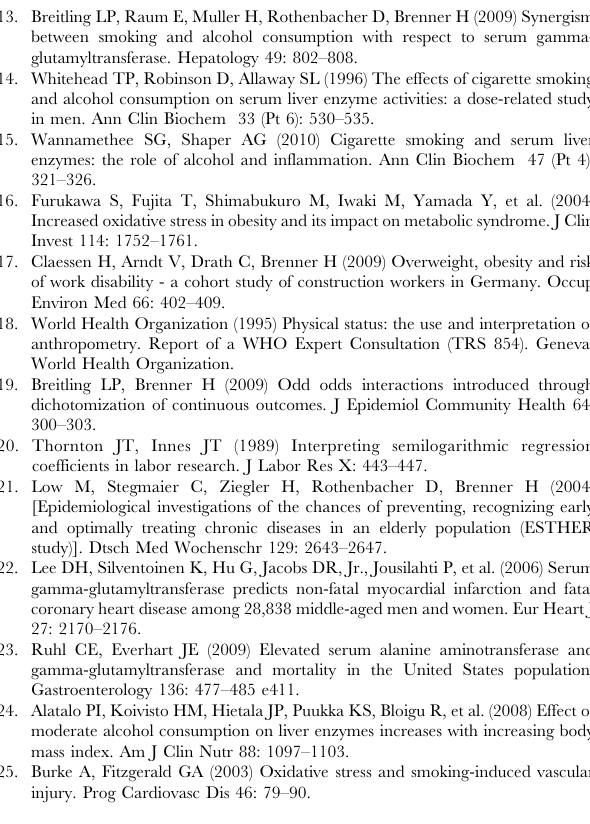
Table S2 Age- and alcohol consumption-adjusted associations between smoking x BMI strata and serum c -GT levels. Reported are odds ratios (OR) from logistic regression models predicting c - GT . 28 U/L (at 25 u C) and results from regression models predicting logarithmically transformed c -GT (expressed as % change in